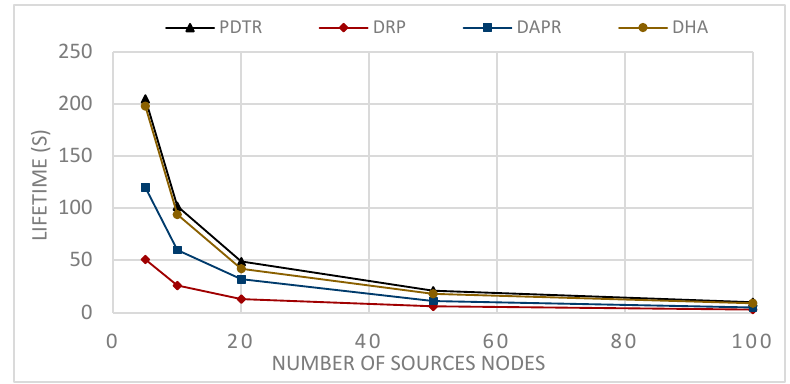
Figure 12. Impact of varying the number of sources nodes on the network lifetime.